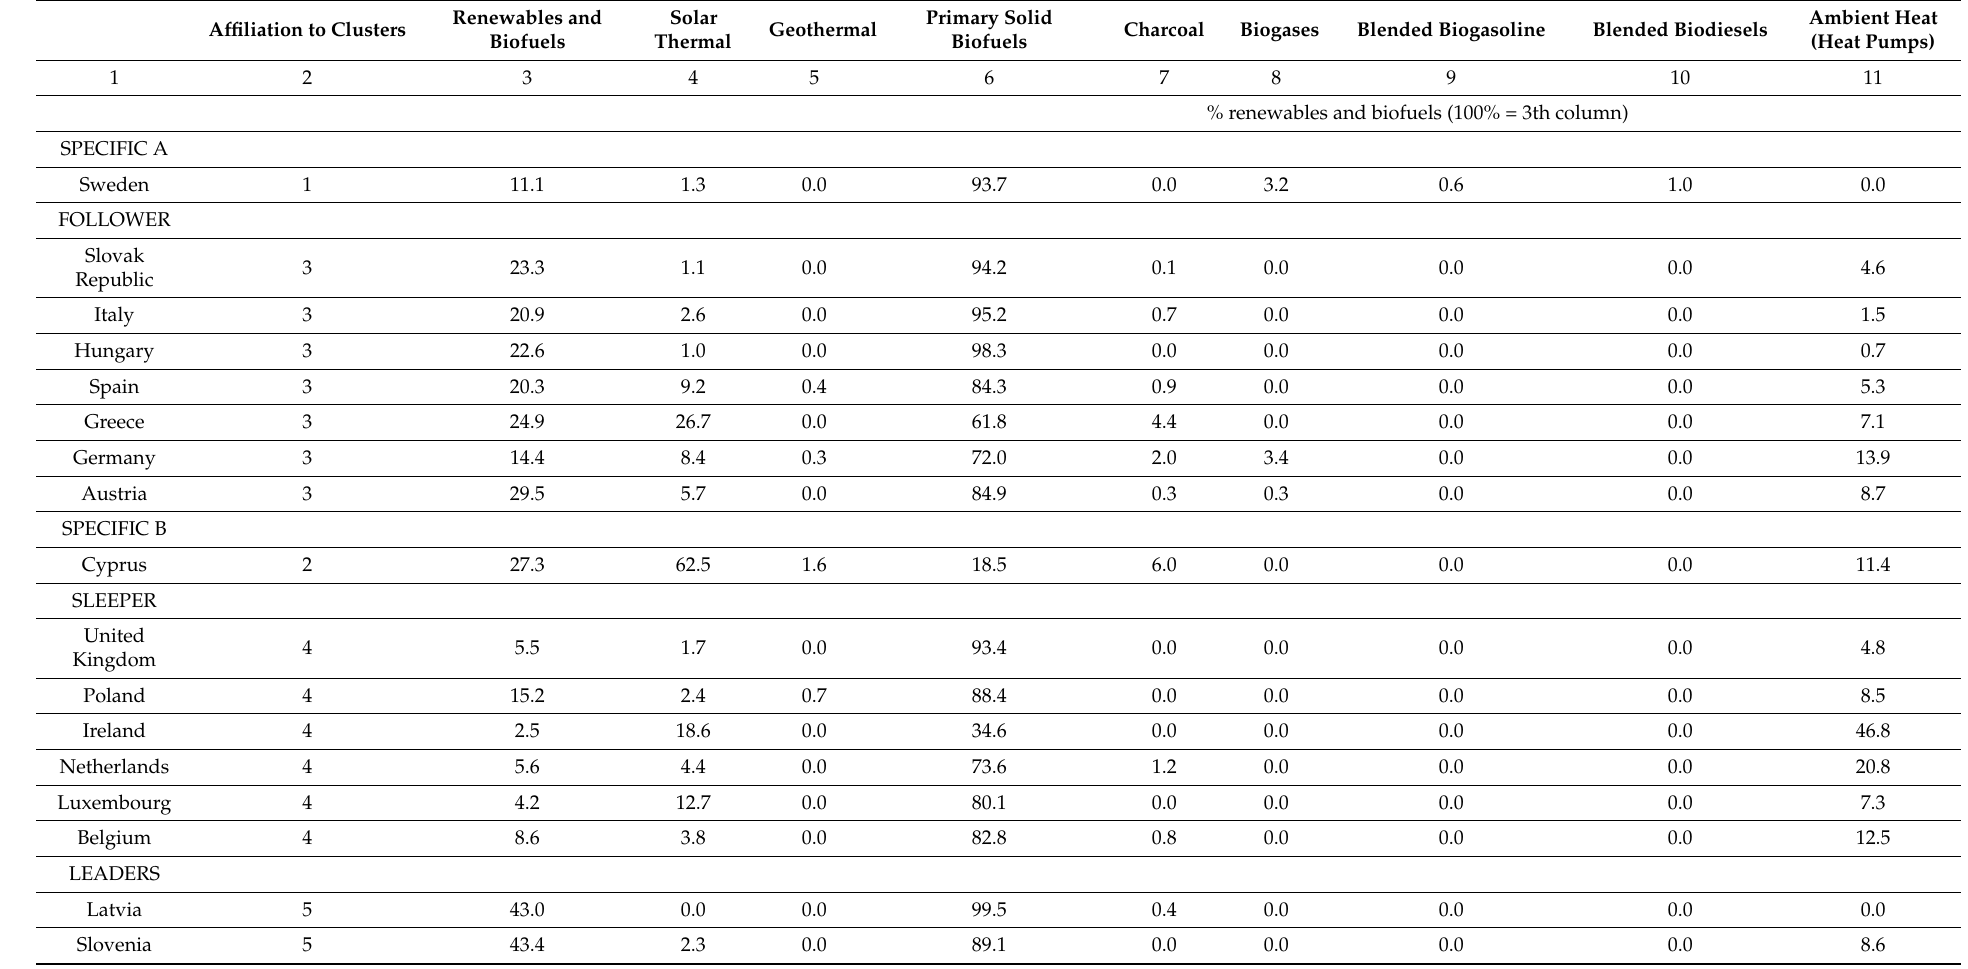
Table 3. Groups of EU-28 countries due to the use of RES in the household sector in 2019, in